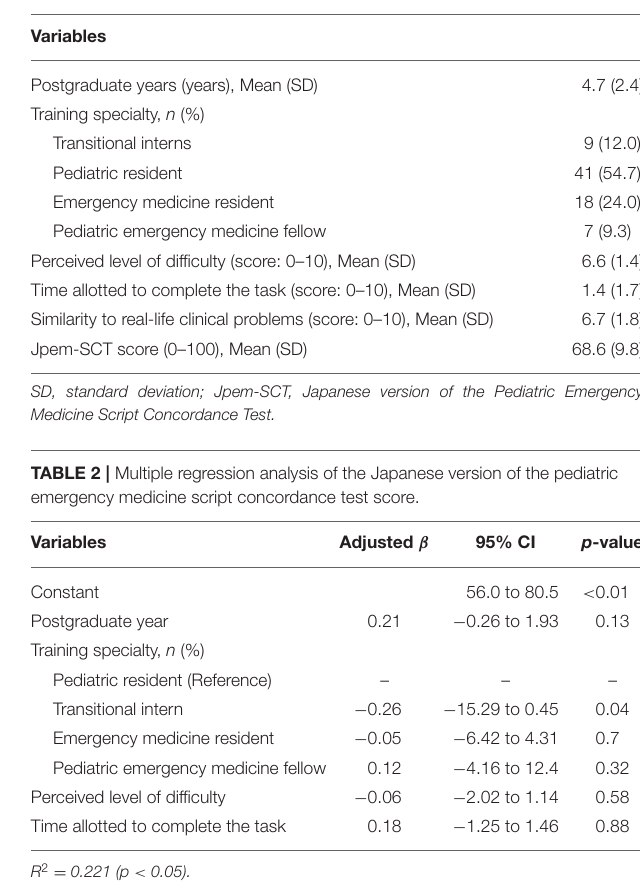
TABLE 1 | Demographics of the participants.